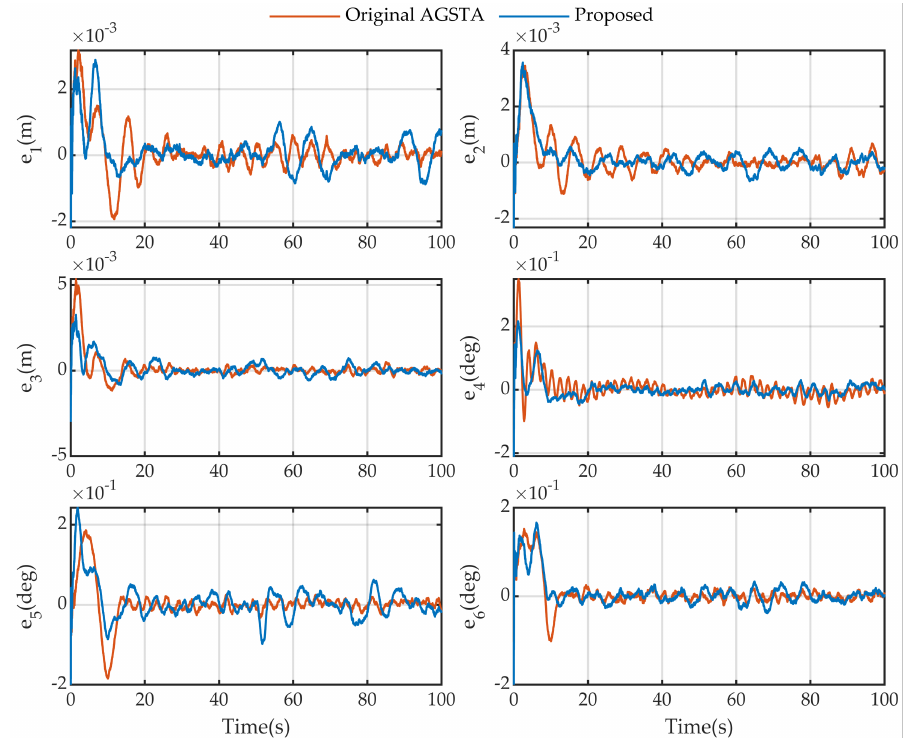
Figure 6. Vehicle state errors during station-keeping